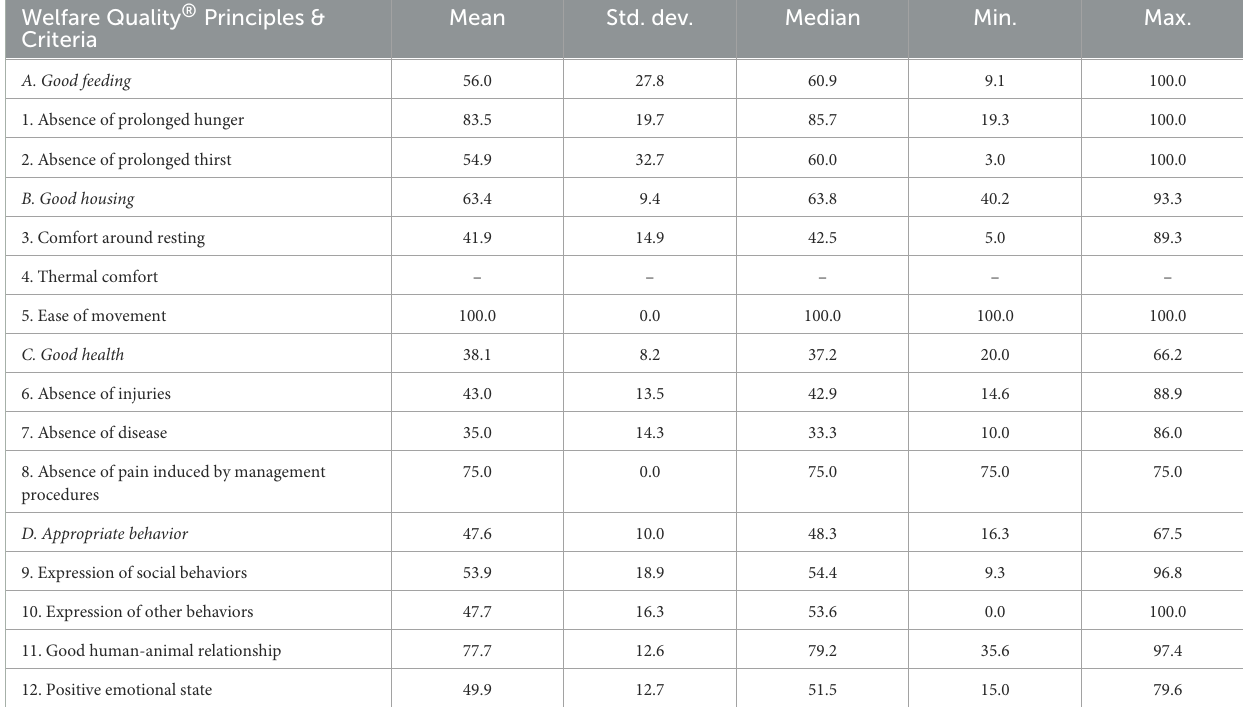
TABLE 4 Summary of Welfare Quality ® scores in Norwegian loose-housed dairy herds ( n = 155) showing the mean, standard deviation of the mean, median, maximum, and minimum for each value. Welfare Quality ® Principles &